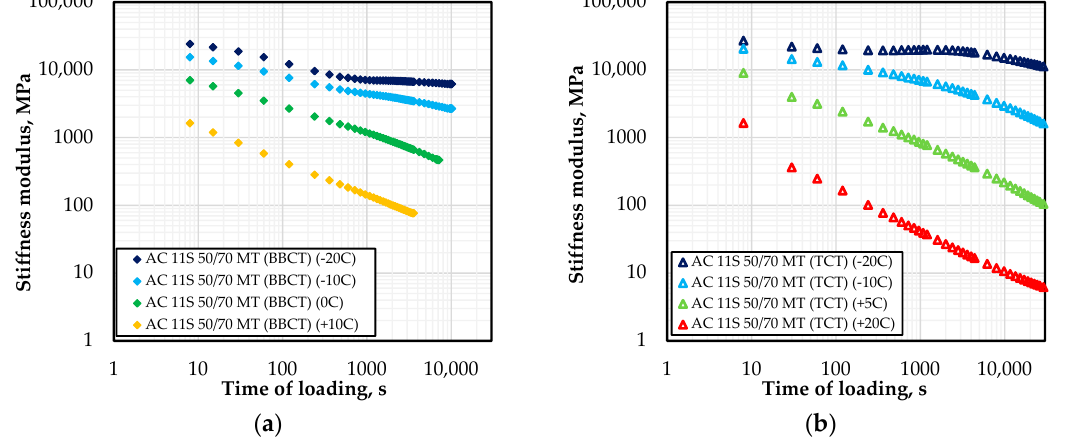
Figure 7. Creep test results—stiffness curves for AC 11S 50/70 MT ( a ) BBCT; ( b ) TCT.